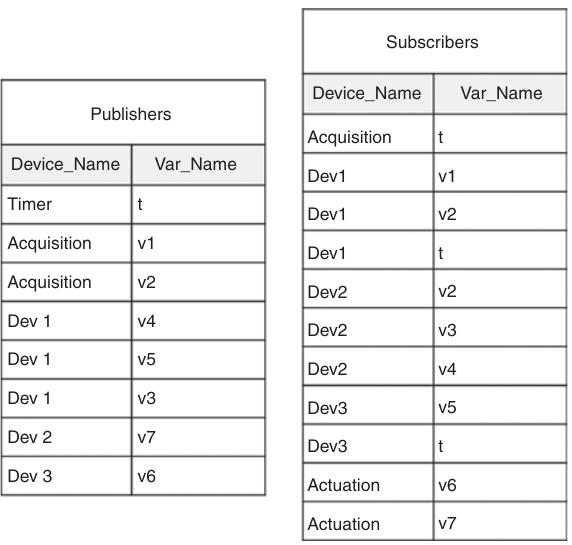
Figure 8: Minimal Contents of Publishers and Subscribers Tables for the Proposed